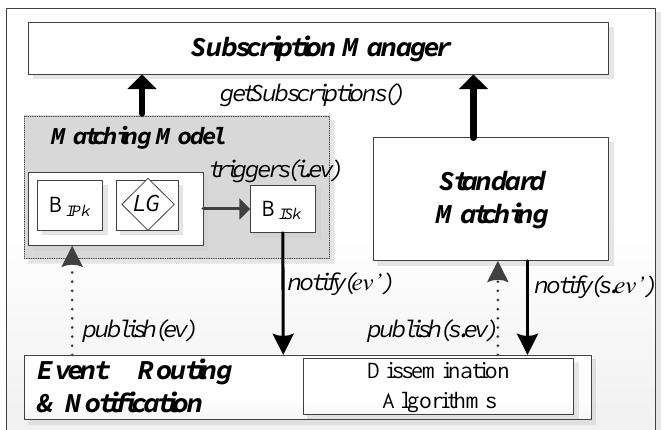
Figure 4. Reference Broker